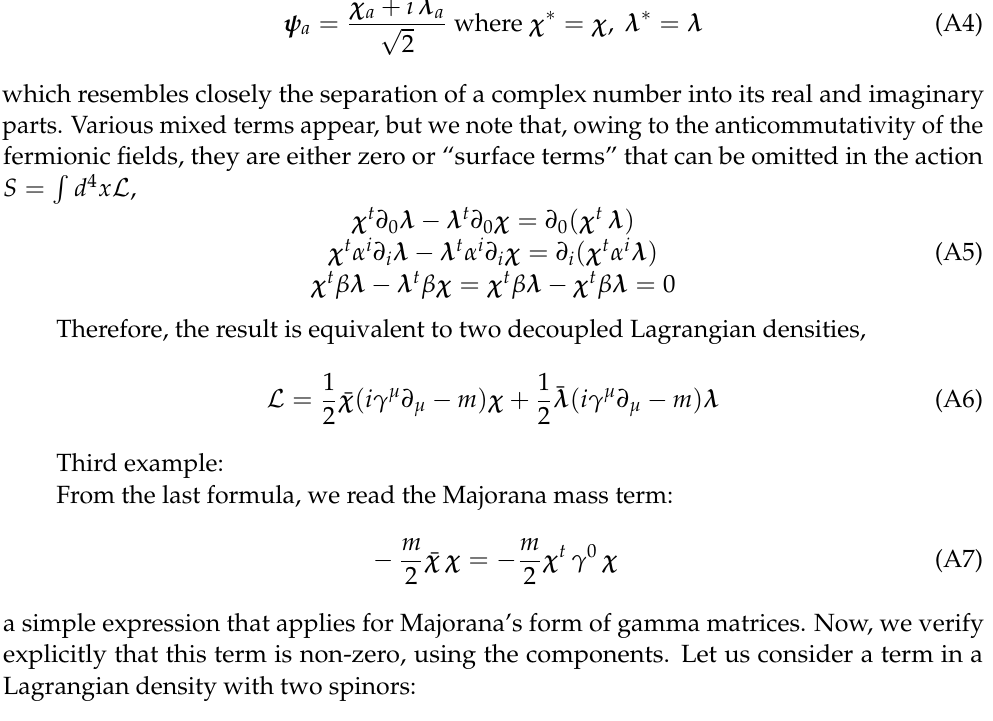
= i γ j γ k . Generators jk